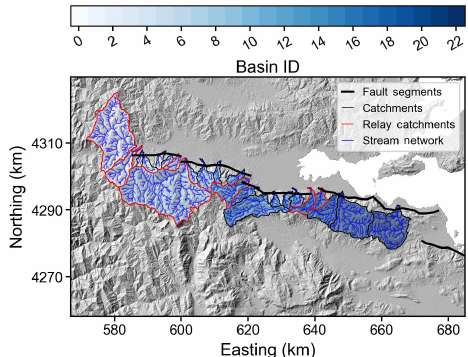
Figure 11. Basins analysed near the Gulf of Evia, Greece, UTM zone 34N, that interact with active normal faults previously studied by Whittaker and Walker